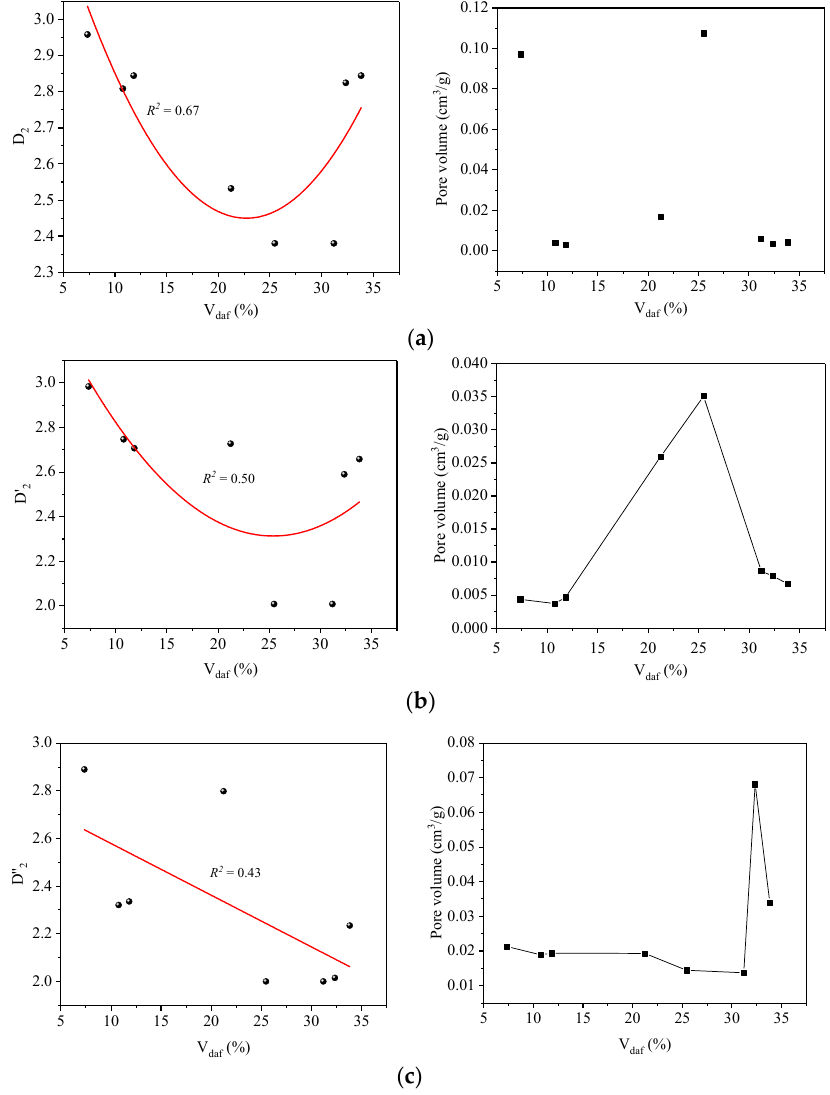
Figure 8. Relationship of V daf with fractal dimensions ( D 2 , D’ 2 and D” 2 ) and pore volume: ( a ) seepage pores; ( b ) transition pores; ( c ) mesopores.